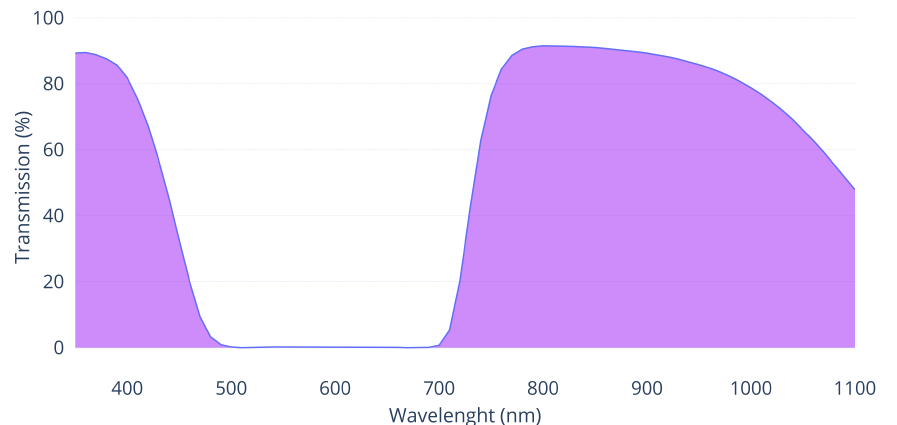
Figure 7. ZB2 filter light transmission curve. (Source: Shijiazhuang Tangsinuo Optoelectronic Technology Co., Ltd.).